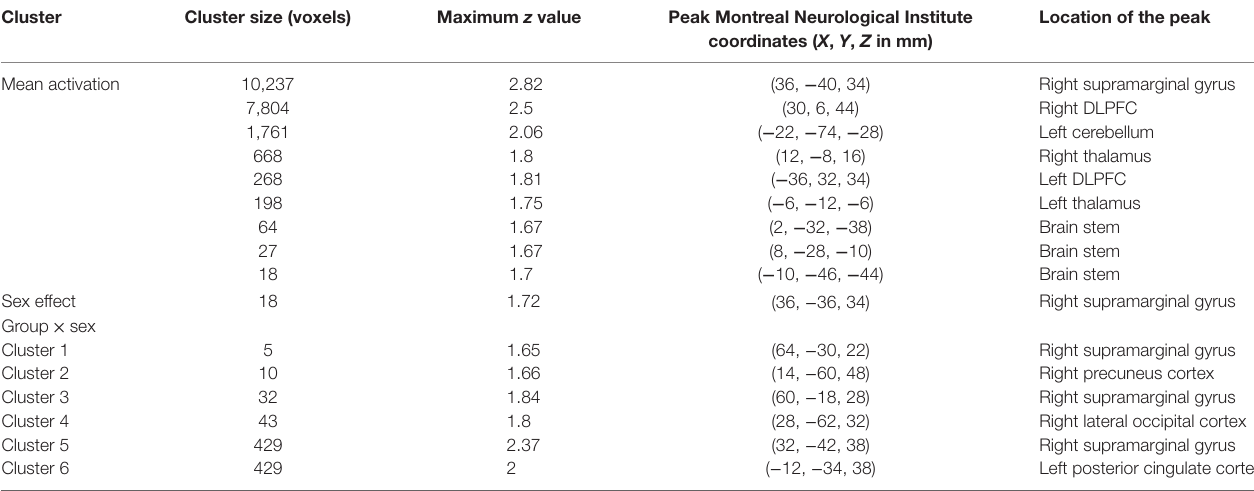
TaBle 3 | Significant mean activation, sex effect and group × sex interactions responding to the sad distractor contrast in all participants.